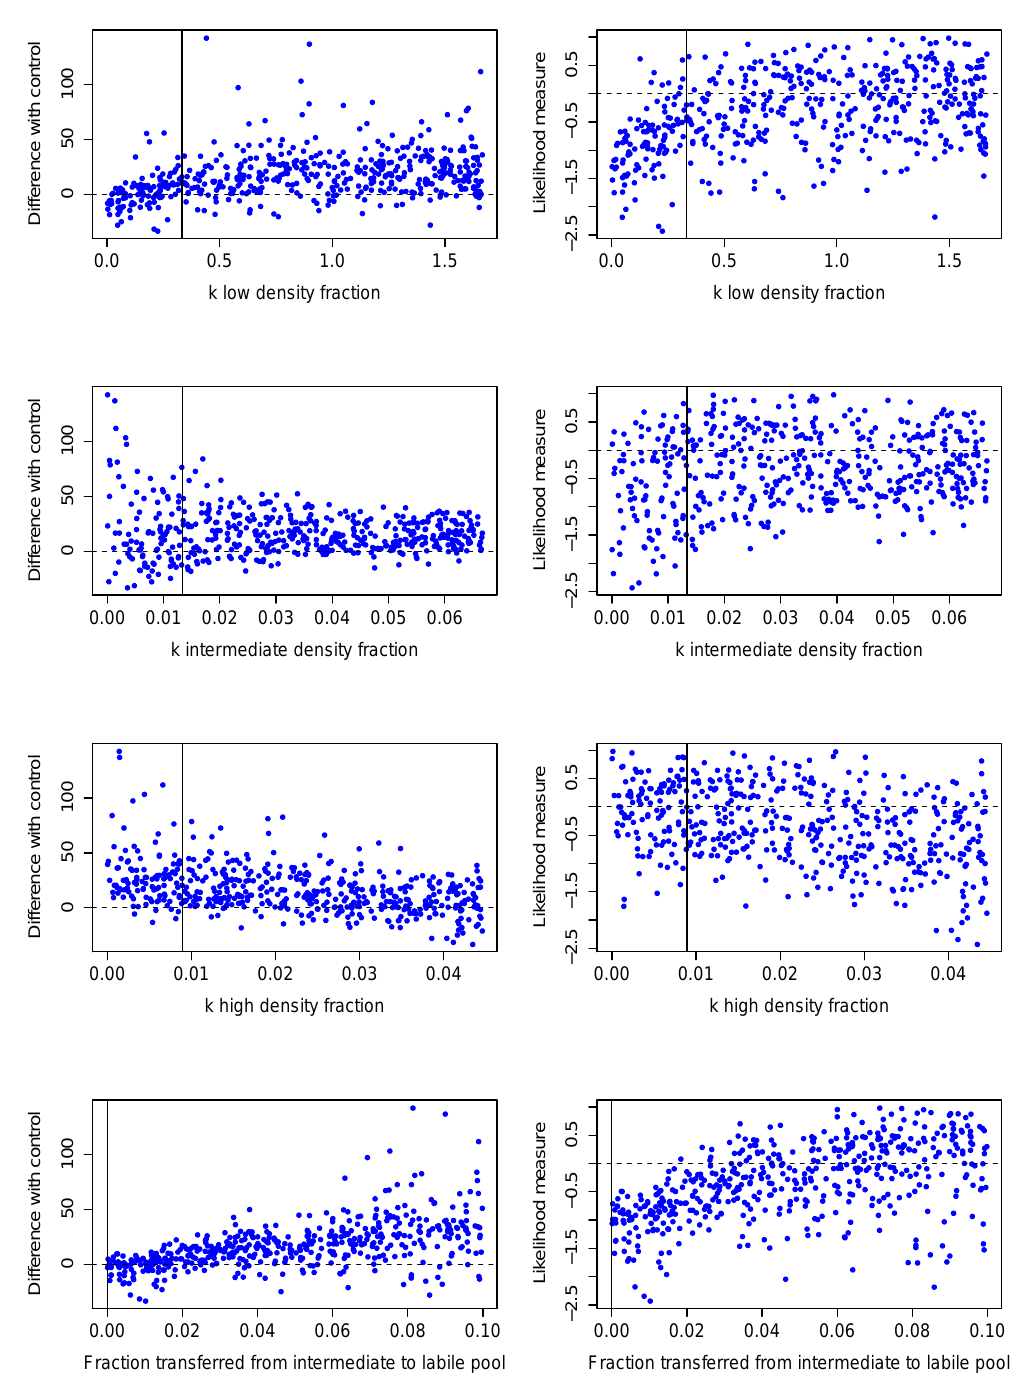
Fig. 10. Dotty plots generated by randomly modifying the values of the decomposition rates and the transfer from the intermediate pool to the labile pool. Panels on the left show the calculated difference between model predictions and observations of 1 14 C values in respired CO 2 for the mineral fractions two months after the start of the experimental manipulations. Panels on the right show the value of the likelihood measure. Positive values in the likelihood measure represent behavioral